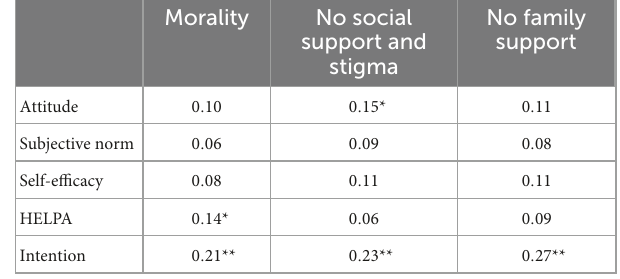
TABLE 7 f 2 effect sizes.